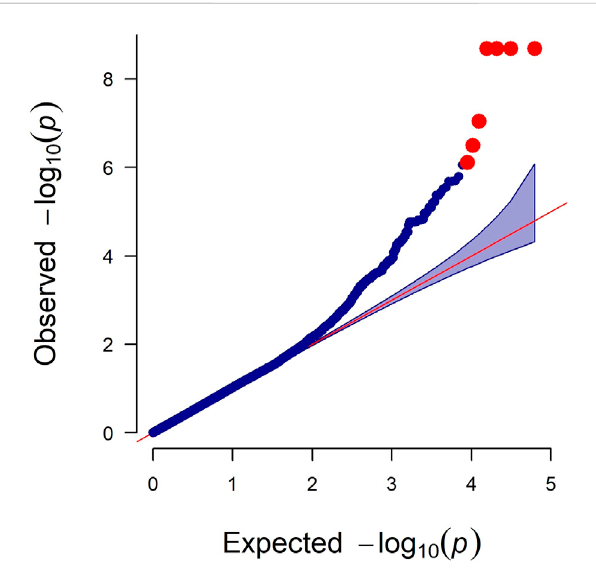
FIGURE 2 Quantile-quantile plot of genome-wide study association study for the primary feather color trait in ducks. The x -axis indicates the expected − log 10 p -values. The y -axis indicates the observed − log10 p